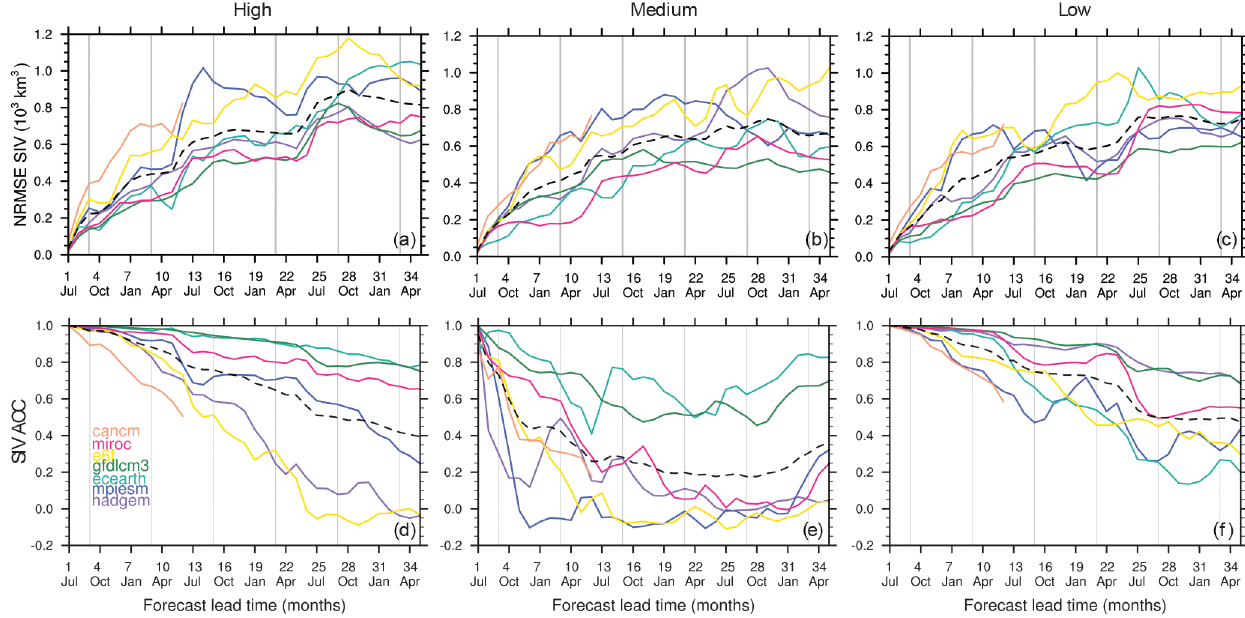
Figure 6. Top row: NRMSE of sea ice extent, but calculated only for start dates with anomalously low, medium or high sea ice volume, relative to the control run climatology. Bottom row: as the top row but for the ACC metric. The black dashed line shows the multi-model average of each metric and grouping. The number of start dates in the low, medium and high bins is two for all models except E6F (three) and CanCM4